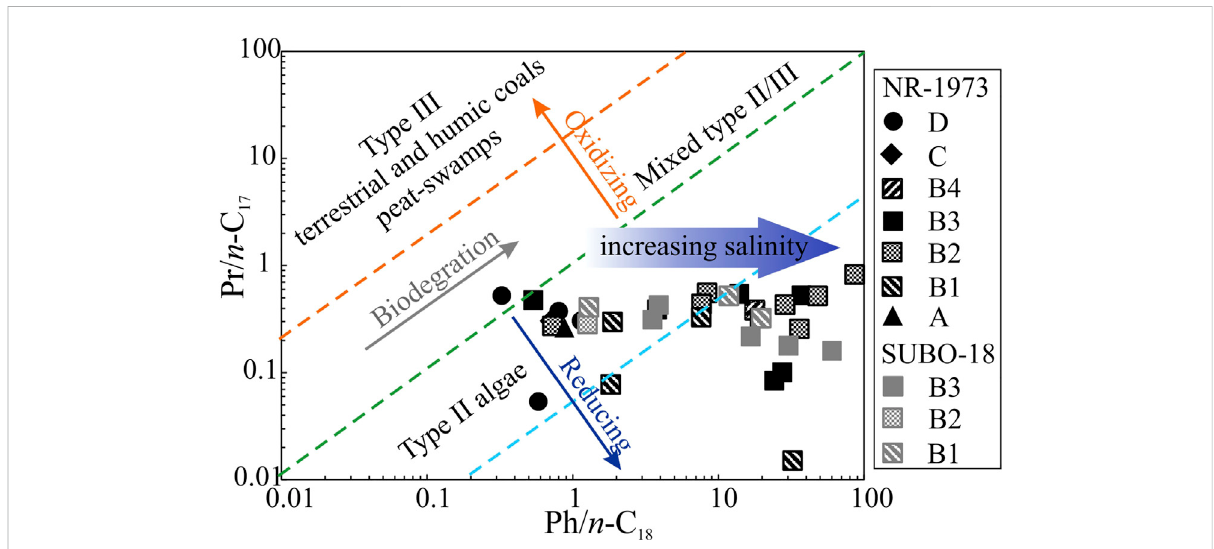
FIGURE 7 Crossplot of Pr/ n- C 17 vs Ph/ n- C 18 of the post-impact sediments in the Nördlinger Ries (modi fi ed after Shanmugam, 1985). See Figure 2 for stratigraphic